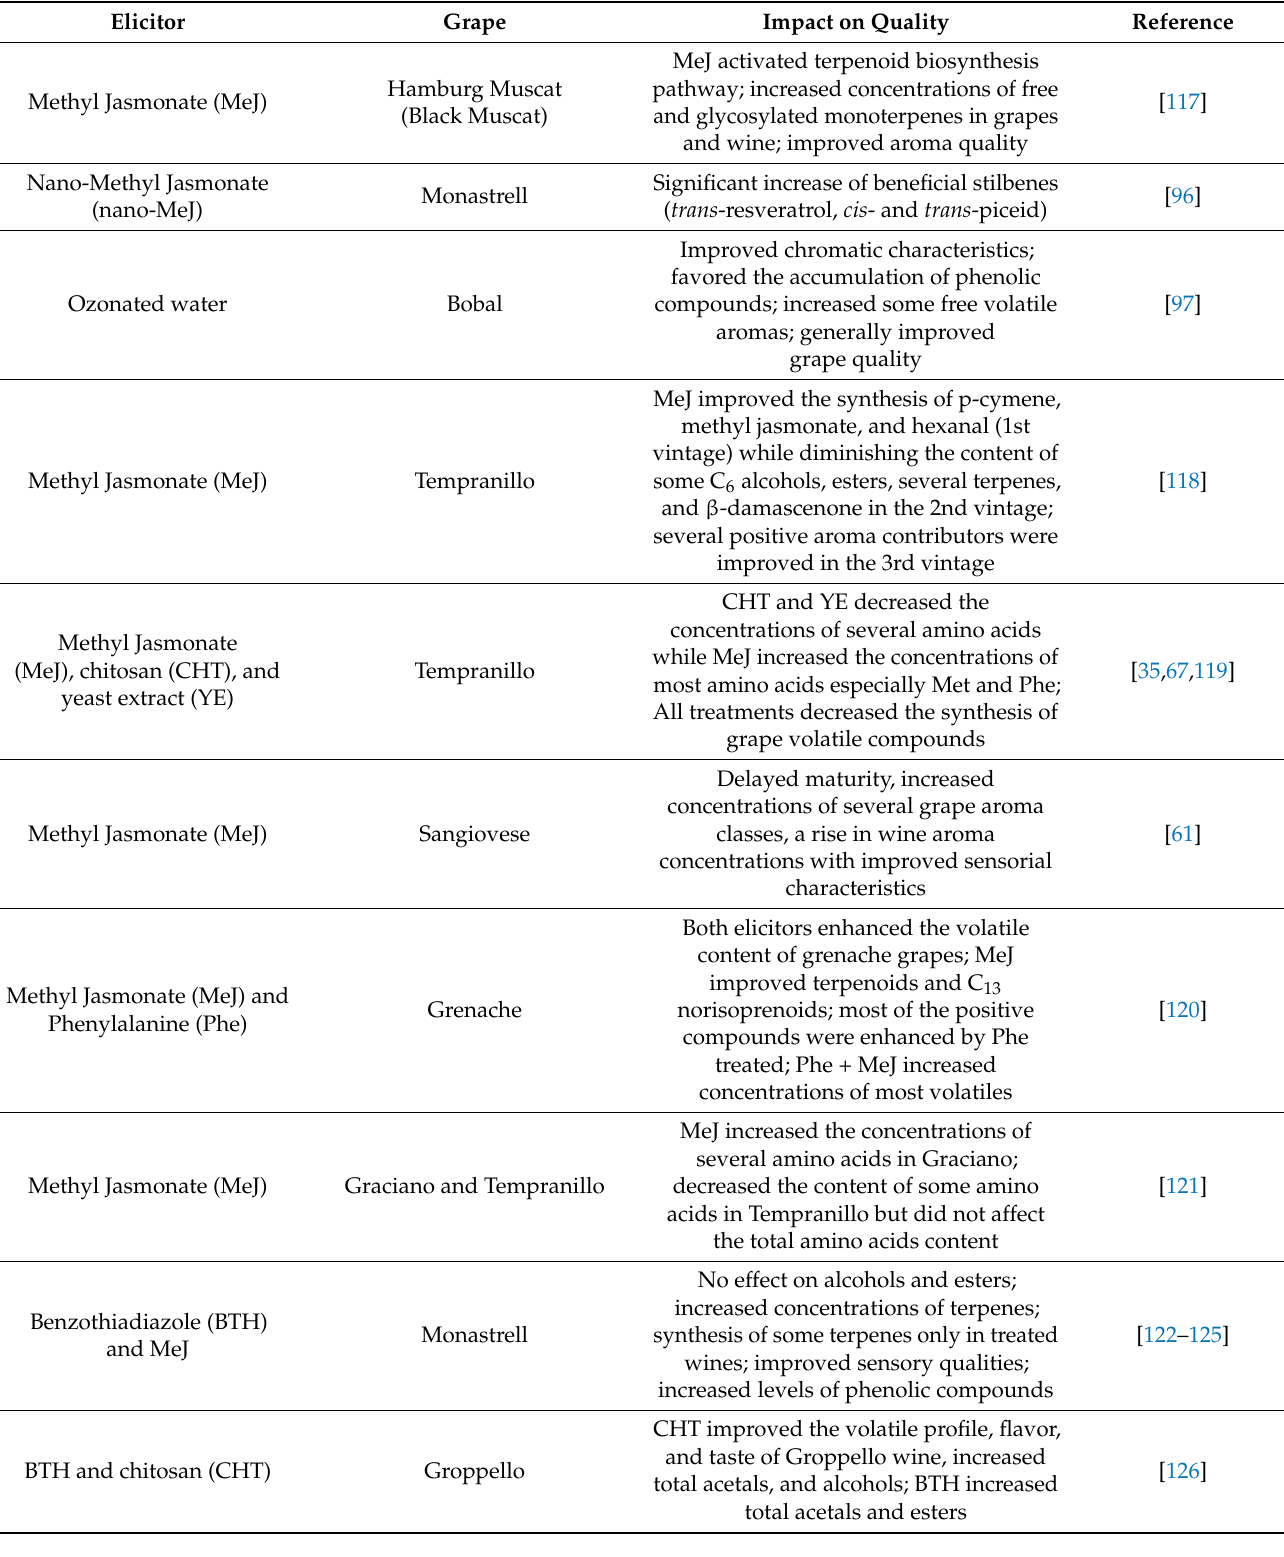
Table 2. Influence of Some Elicitors on Grape and Wine